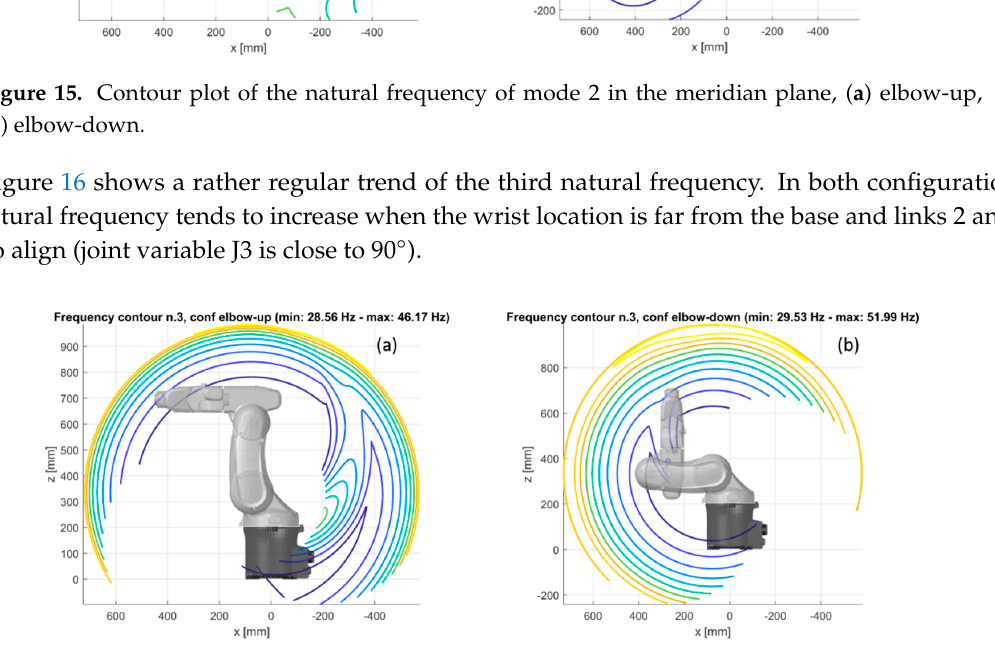
Figure 16. Contour plot of the natural frequency of mode 3 in the meridian plane, ( a ) elbow-up, ( b ) elbow-down.